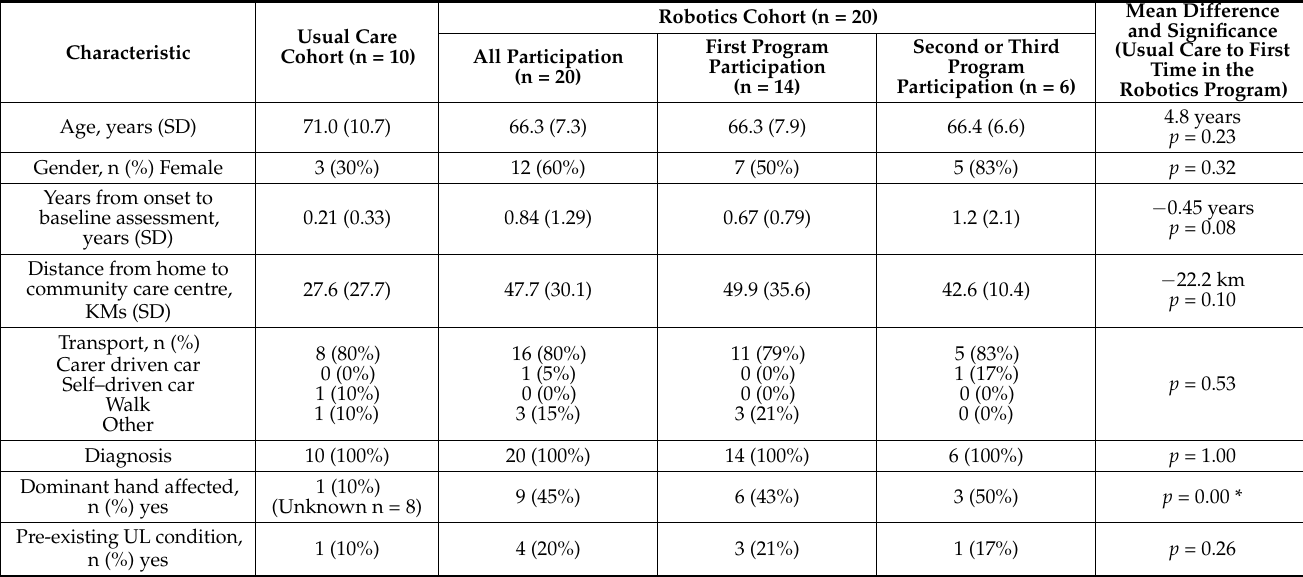
Figure 3. Ratio of staff to patient time.